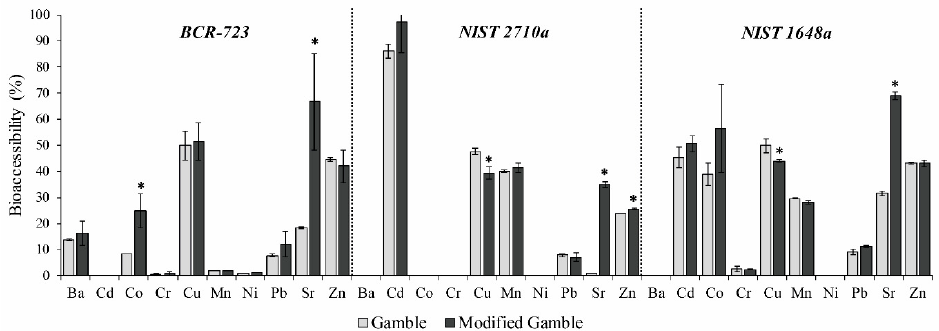
Figure 2. Bioaccessibility values (%; mean ± SD; n = 3) of metallic elements in the three reference materials for a S/L ratio of 1/5000 in Gamble’s solution and modified Gamble’s solution. * denotes significant differences ( p < 0.05) between both Gamble’s solution and modified Gamble’s solution.